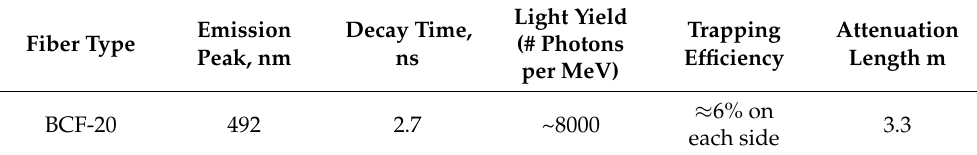
Table 1. Characteristics of the chosen scintillating fiber as reported by the manufacturer.